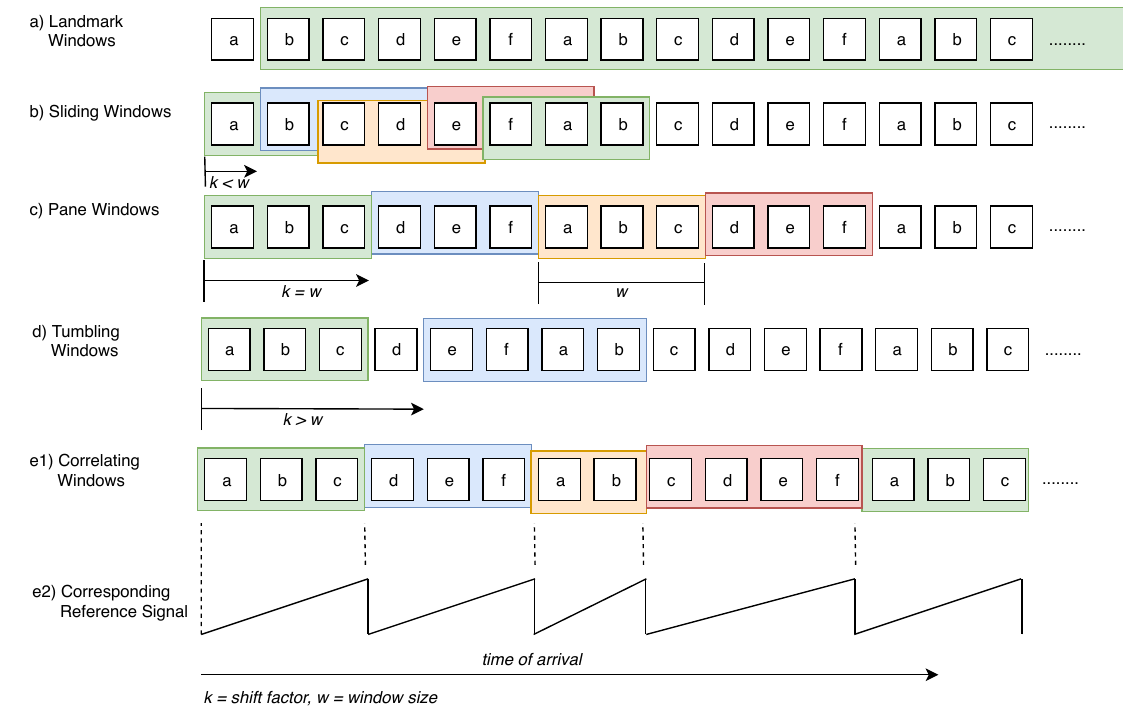
Figure 5. Window types and sliding window